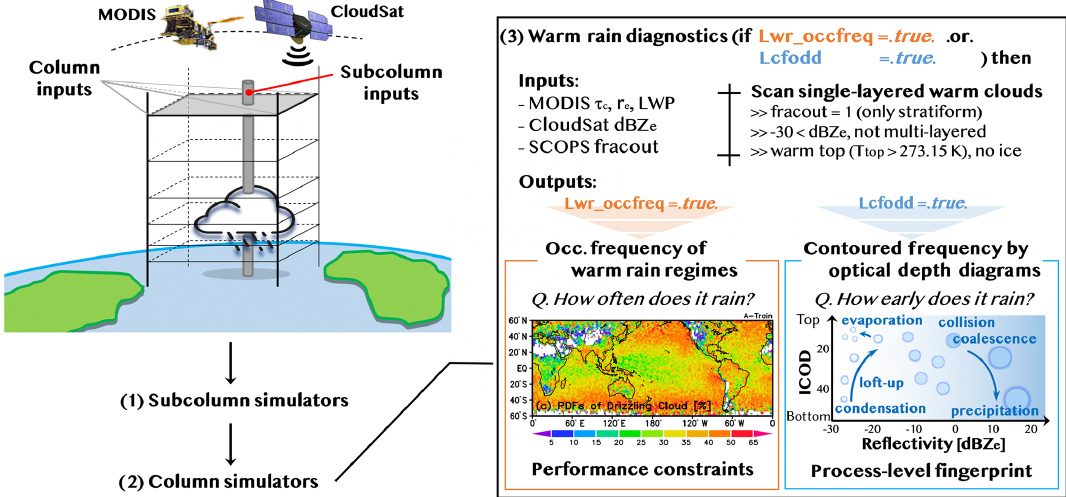
Figure 1. Schematic flowchart of COSP2 (see also Swales et al., 2018, for details) and additional processes for warm rain diagnostics introduced in this